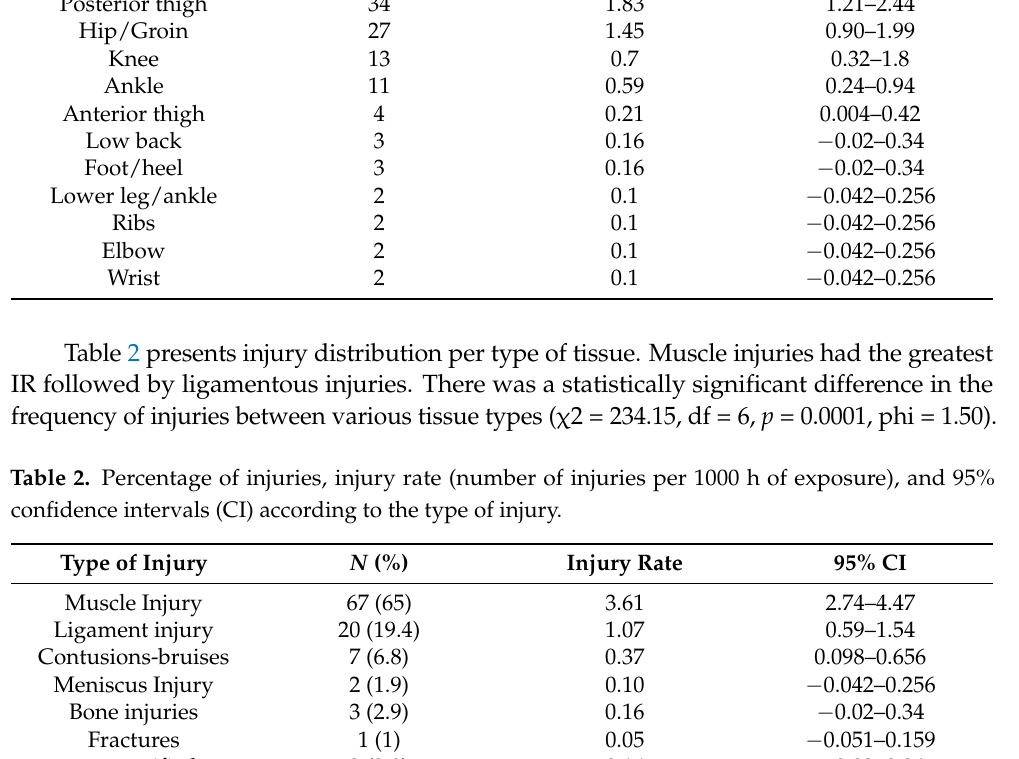
Table 1. Number of injuries, injury rate (number of injuries per 1000h of exposure), and 95% confidence intervals (CI) according to anatomical location.